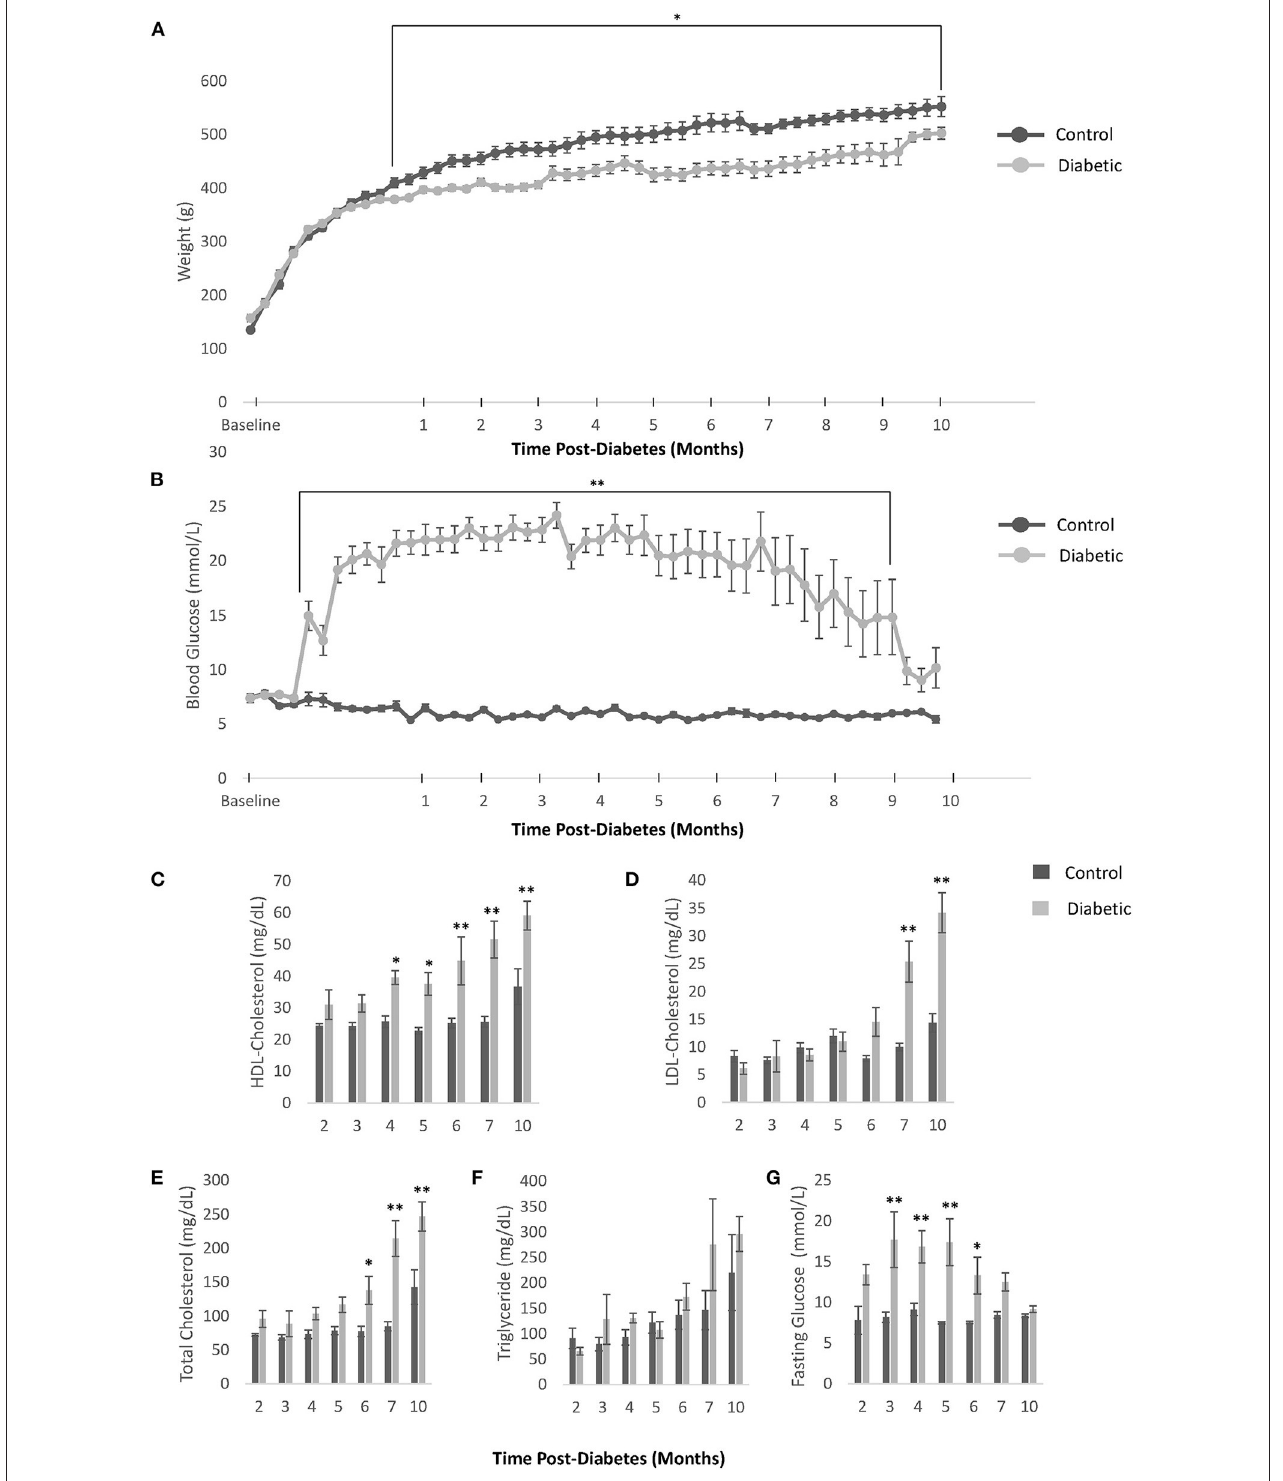
FIGURE 2 | Body weight, blood glucose, and blood cholesterol levels. (A) Weekly weight measurements in all control and diabetic male rats. (B) Weekly non-fasting blood glucose measurements in all control and diabetic male rats. For (C–G) , data was obtained from n = 3 male control/diabetic at Month 2 post-diabetes; n = 5 male control/diabetic for Month 3–7; and n = 4 male control, n = 6 male diabetic at Month 10. (C) High-density lipoprotein (HDL) cholesterol over time. (D) Low-density lipoprotein (LDL) cholesterol over time. (E) Total cholesterol over time. (F) Triglyceride levels over time. (G) Fasting glucose blood levels over time. Significance at individual timepoints is indicated (* p < 0.05), (** p < 0.01). Data represented as mean ± SEM.